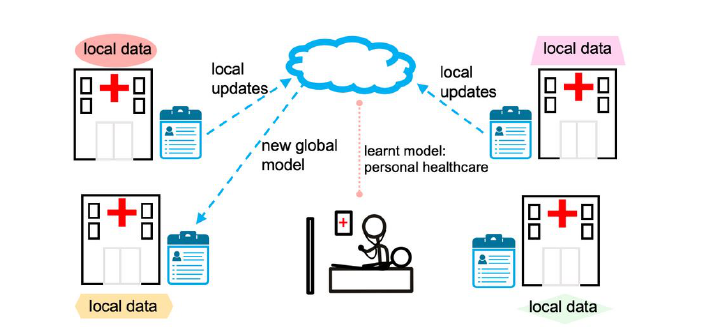
Figure 1. How FL can be used to improve predictive healthcare ML using sensitive data across multiple hospitals